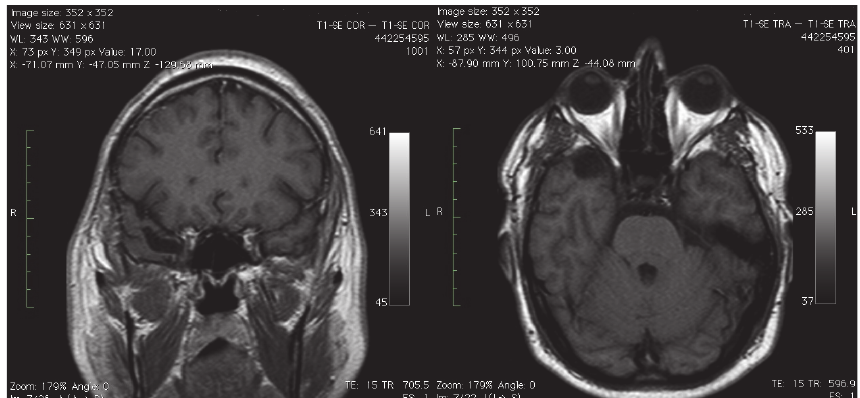
Figure 6: An MRI scan performed 5 months after surgery shows complete removal of the tumour.